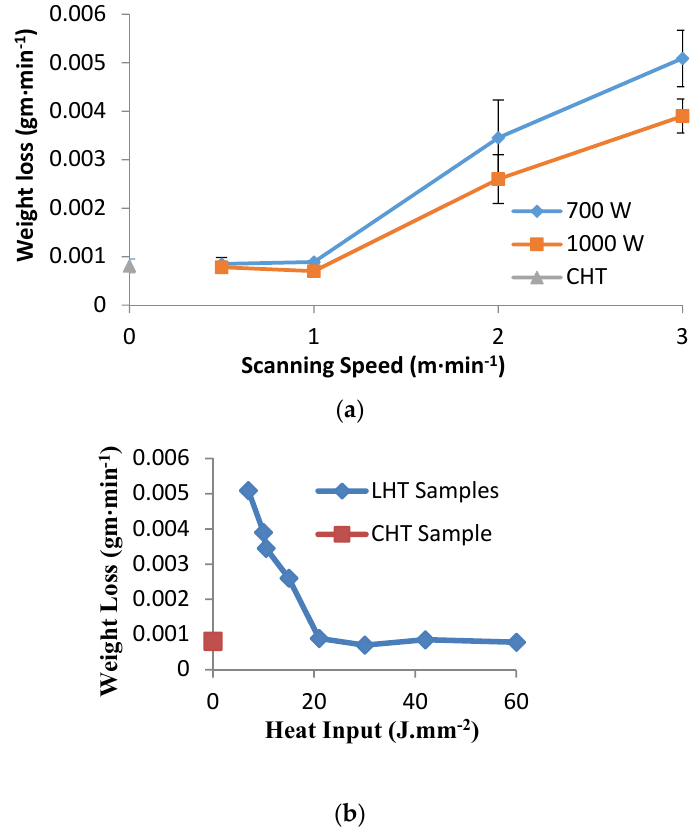
Figure 14. Wear behaviors of CHT and LHT samples, ( a ) weight loss vs. scanning speed; ( b ) weight loss vs. heat input.